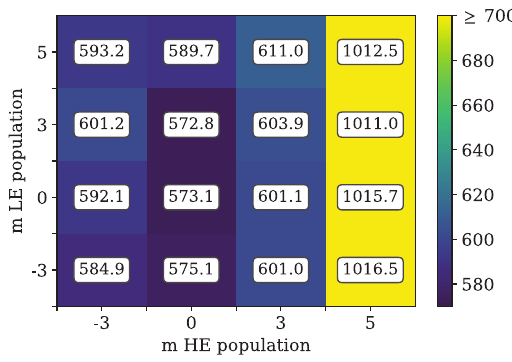
Figure 5. The total deviance is colour-coded as in the right bar and shown for all the possible combinations of source evolution of the two populations. The values of m are shown on the